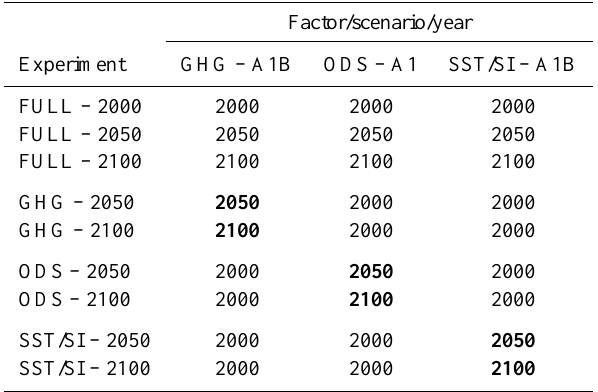
Table 1. The list of the numerical experiments performed with CCM SOCOL 2.0. (Bold font marks the factor/year, in which con- tribution is studied by an